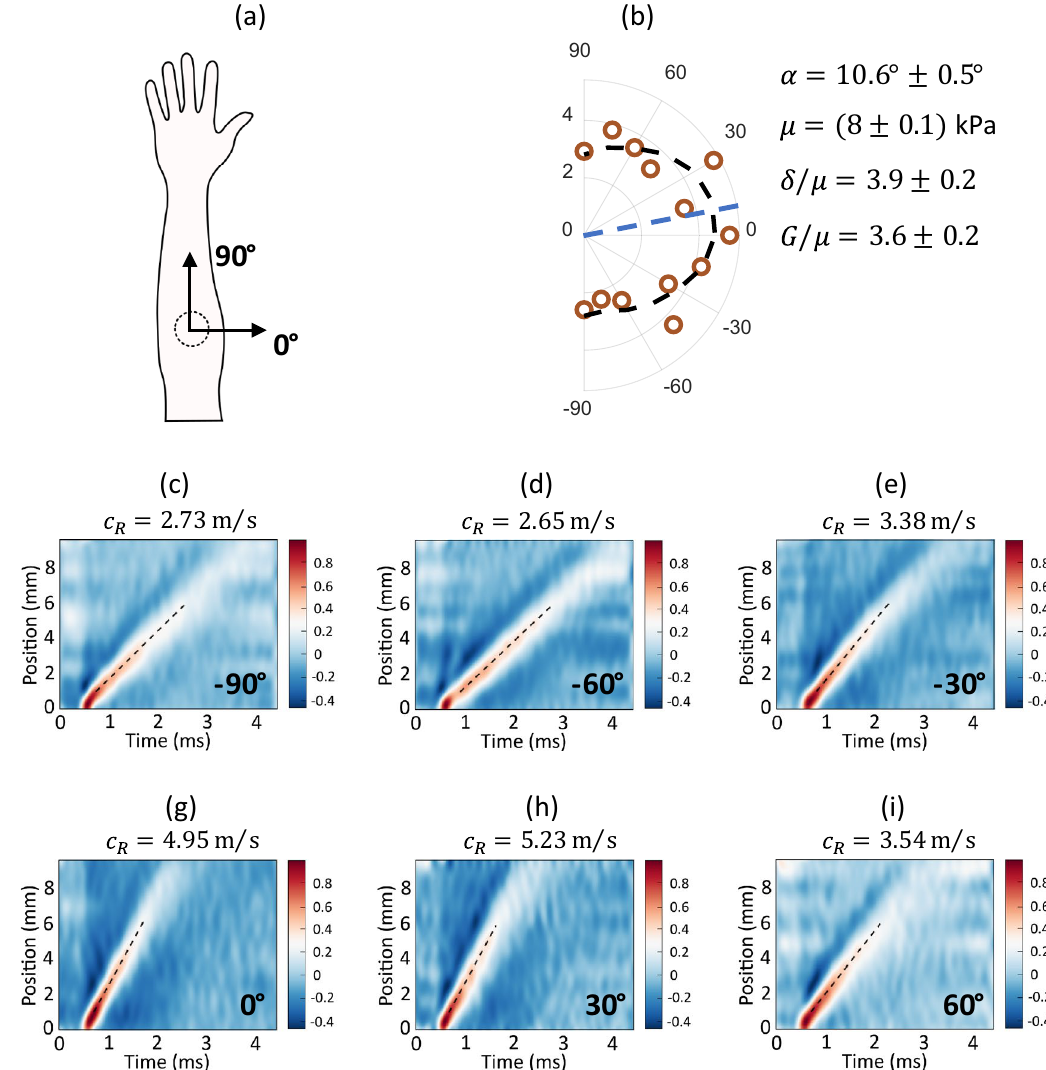
Figure 2. An example of in-plane anisotropy of Rayleigh wave propagation in skin (forearm body area, Subject #4). ( a ) Schematic of the measurement site. Imaging of propagating mechanical waves was performed with AμT-OCE in different propagation directions in human forearm in vivo. Zero propagation angle ϑ corresponds to the direction perpendicular to the axial forearm direction, which corresponds to the direction of traditional Langer’s lines. ( b ) Measured anisotropy of Rayleigh wave speed in Subject #4 (dots) and the best fit to the analytic solution derived from the NITI model (see Supplementary Note 3). The defined orientation of the ◦ mechanical symmetry axis (Langer’s lines) α = ( 10.6 ± 0.5 ) , and the shear modulus µ and anisotropy factors correspond to the values at minimum fit error. ( c – i ) Measured wavefields of Rayleigh waves at different in-plane propagation